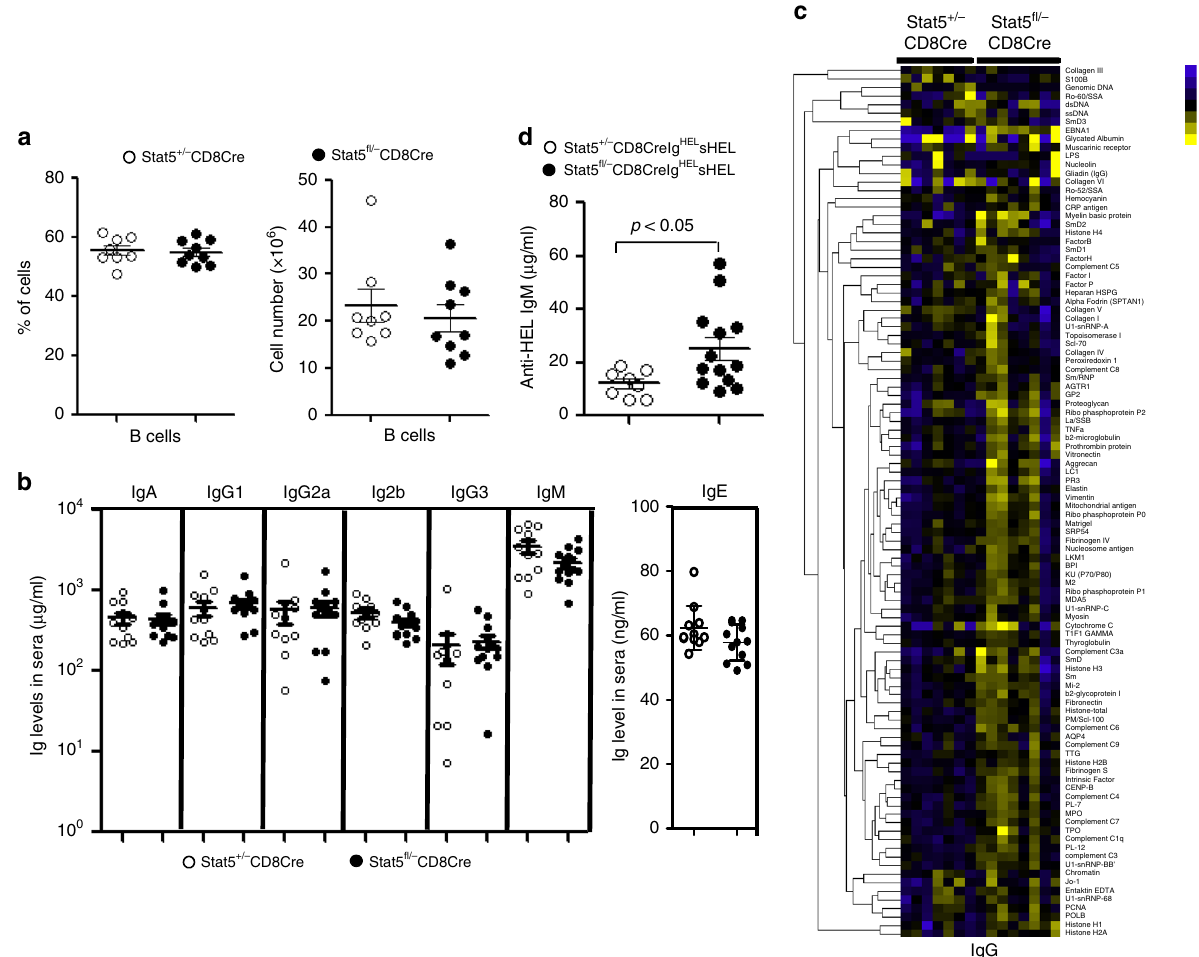
Fig. 2 Increased autoantibody production in Stat5 fl / − CD8Cre mice. a Normal numbers of splenic B cells in Stat5 fl / − CD8Cre mice. Splenocytes from Stat5 + / − CD8Cre and Stat5 fl / − CD8Cre mice were stained with anti-B220. Dot plots show percentages of B220 + B cells (left) and numbers of total splenocytes and B220 + B cells (right) in the spleen. Each dot represents an individual mouse and horizontal bars indicate mean values. Mean ± SD is shown. b Normal serum Ig levels in Stat5 fl / − CD8Cre mice. The serum levels of the Ig isotypes in 2-month-old Stat5 + / − CD8Cre and Stat5 fl / − CD8Cre mice were determined. Each dot represents an individual mouse and horizontal bars indicate mean values. Mean ± SD is shown. c Increased IgG autoantibody production in Stat5 fl / − CD8Cre mice. The sera from 2-month-old mice were screened by the autoantigen array. d Self-tolerance breakdown in Stat5 fl / − CD8CreIg HEL sHEL mice. Dot plots show the serum levels of HEL-speci fi c IgM in 2-month-old Stat5 + / − CD8CreIg HEL sHEL and Stat5 fl / − CD8CreIg HEL sHEL mice. Each dot represents an individual mouse and horizontal bars indicate mean values. Mean ± SD is shown. P -values were calculated with the unpaired two-tailed Student ’ s t -test. Data shown are obtained from 8 ( a ), 11 ( b ) or 7 ( c ) Stat5 + / − CD8Cre/YFP, 9 ( a ), 13 ( b ) or 8 ( c ) Stat5 fl / − CD8Cre/ YFP mice, 8 ( d ) Stat5 + / − CD8CreIg HEL sHEL and 13 ( d ) Stat5 fl / − CD8CreIg HEL sHEL mice. Source data are available as a source data fi